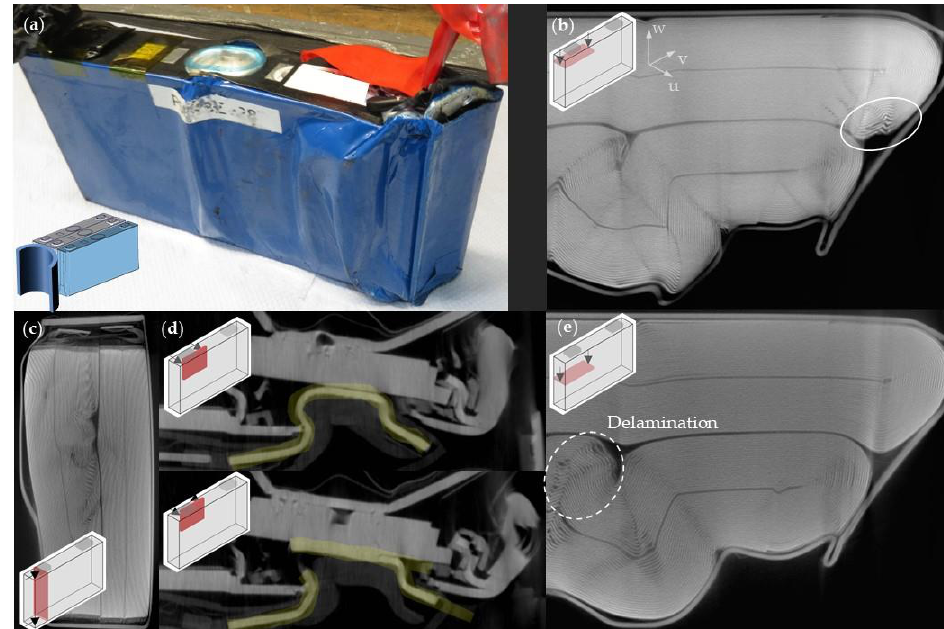
Figure 16. V-direction with cylindrical impactor: ( a ) deformed right cell; ( b – e ) CT-Scans.